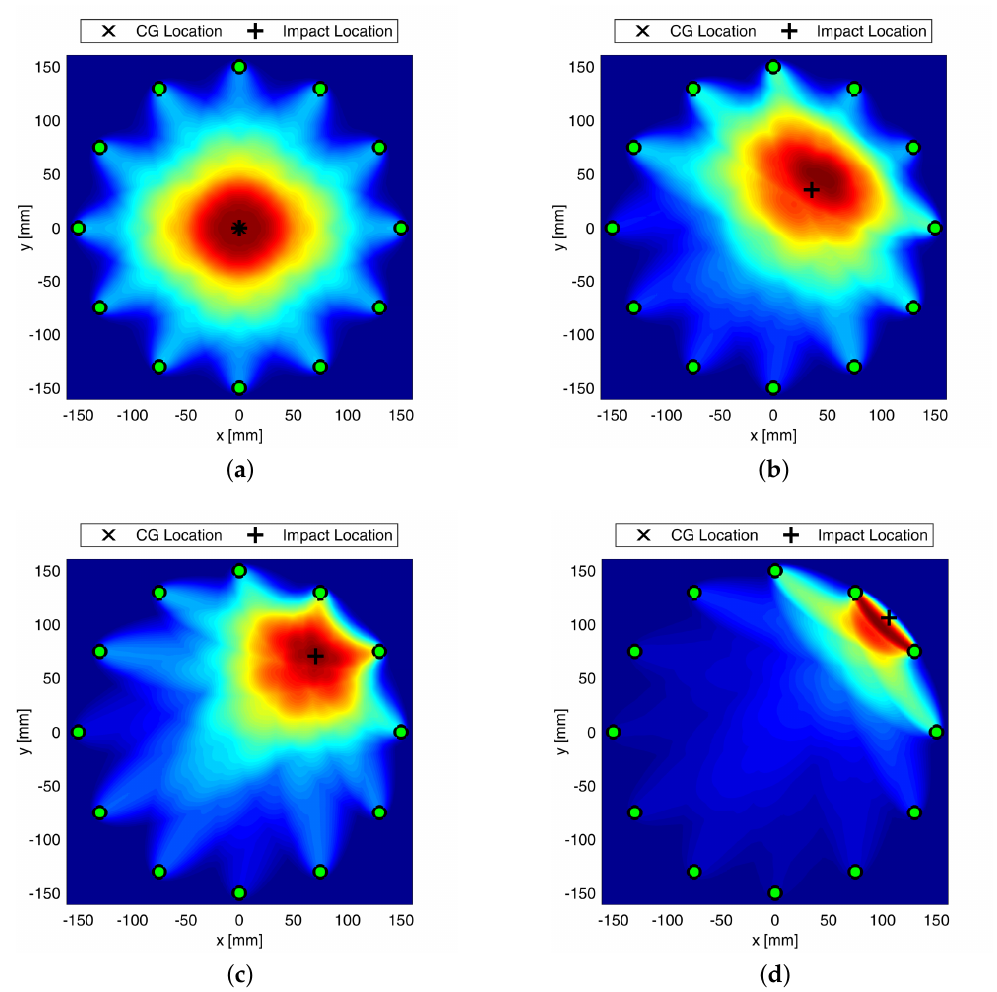
Figure 9. Maps of Damage Probability Index using elliptic weight distribution function and relying on data fusion based damage indicator at 0 mm ( a ), 50 mm ( b ), 100 mm ( c ), and 150 mm ( d ) far away from the center. Colorbar in between 0 and 1. SHM carried out at 50